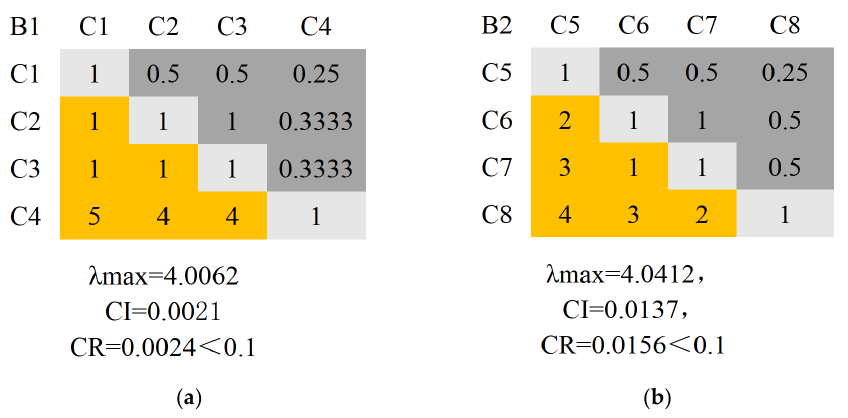
Figure 9. ( a ) Pairwise comparison matrix of building structures; ( b ) Pairwise comparison matrix of land-use function patterns. Table 5. Hierarchy and metric weight of SSSBI model.